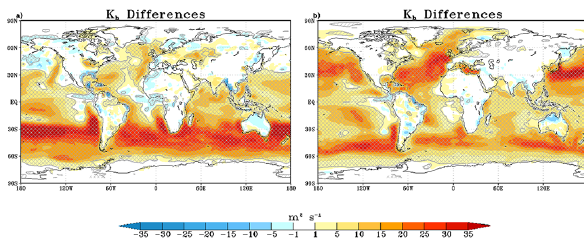
Figure 3. Seasonal mean turbulent eddy diffusion coefficient at 925hPa differences (Method 3 minus Method 2) for JJA (a) and DJF (b) . Hatch marks represent significance at the 90% level using the Student’s t test. Crosshatch marks represent significance at the 95%